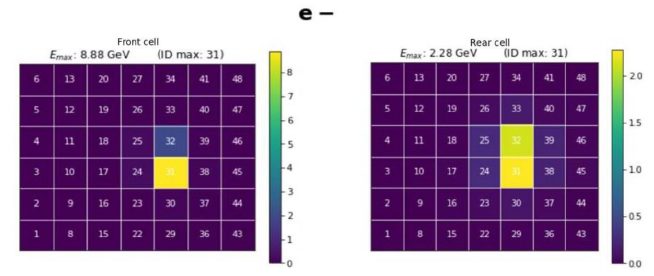
Figure 1. Particles draw patterns as they cross the detectors [5].